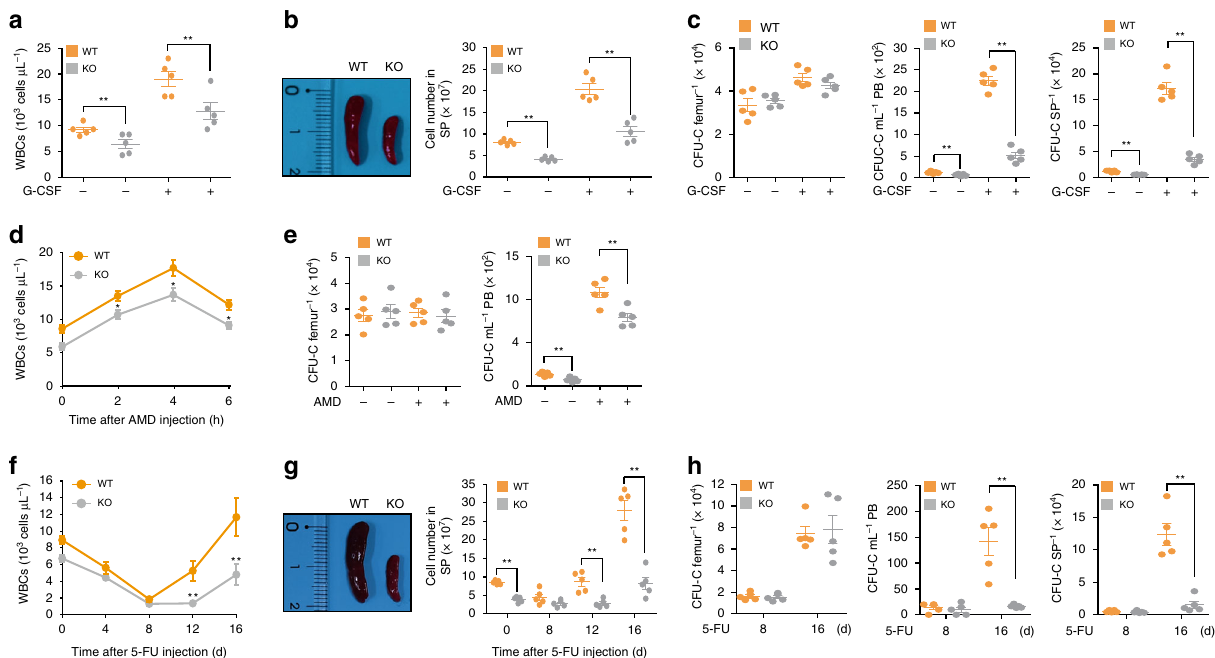
Fig. 2 Impaired mobilization of KO HSPCs from the BM into the periphery. a Comparison of WBC counts between WT and KO mice on day 5 after G-CSF treatment. n = 5. b Representative image of spleens from WT and KO mice (left) and absolute numbers of splenocytes (right) for WT and KO mice on day 5 after G-CSF treatment. n = 5. c CFU-C in the BM (femur), PB, and spleen (SP) of WT and KO mice on day 5 after G-CSF treatment. n = 5. d Comparison of WBC counts between WT and KO mice 3 h after AMD3100 treatment. n = 5. e CFU-C in the BM (femur) and PB of WT and KO mice 3 h after AMD3100 treatment. n = 5. f Comparison of WBC counts between WT and KO mice at indicated time points after 5-FU treatment. n = 5. g Representative image of the spleen from a WT or KO mouse (left) and absolute number of splenocytes (right) for WT or KO mice at indicated time points after 5-FU treatment. n = 5. h CFU-C in the BM (femur), PB, and spleen (SP) of WT and KO mice at indicated time points after 5-FU treatment. n = 5. “ − “ , before treatment with G-CSF or AMD3100; “ + “ , after treatment with G-CSF or AMD3100. Statistical signi fi cance was assessed by two-tailed Student ’ s t- test. ** P < 0.01. All data are presented as the mean ± SEM. Source data are provided as a Source Data File